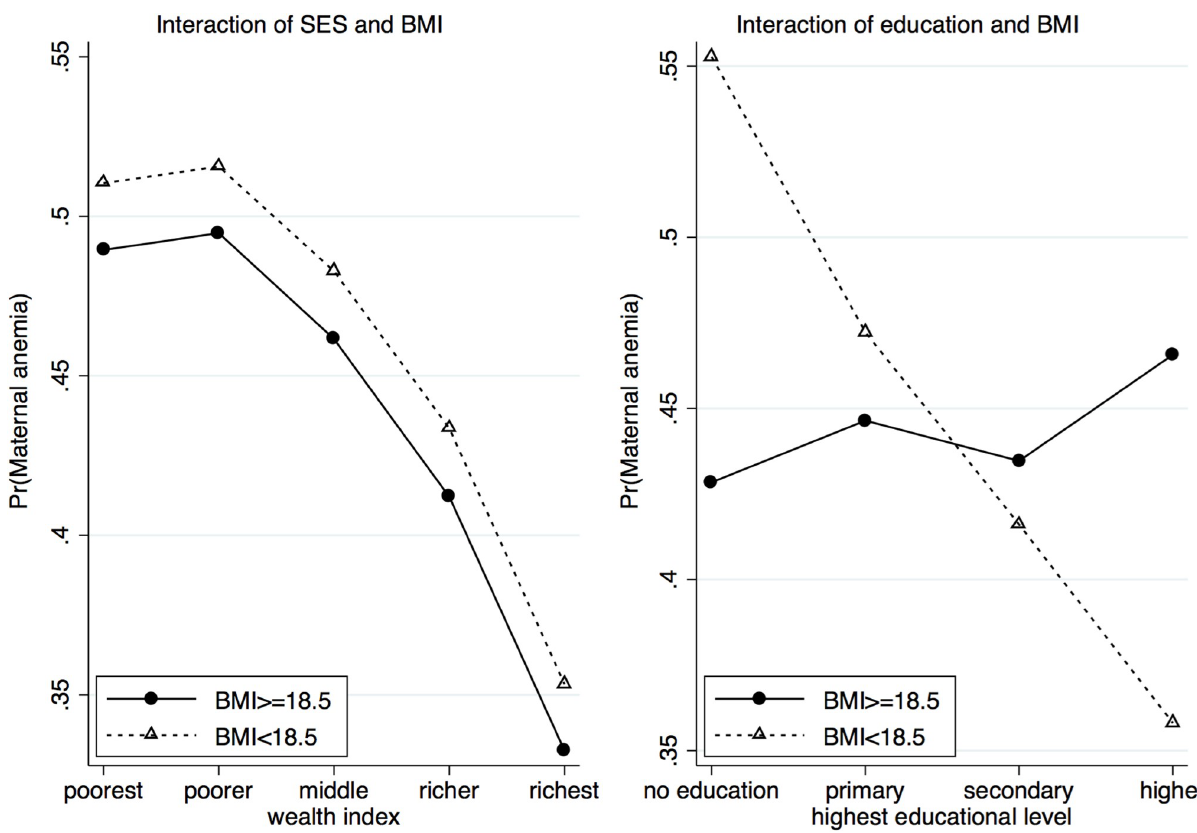
Fig 4. Interaction plot describing the association of BMI interact with SES and education, separately on the risk of maternal